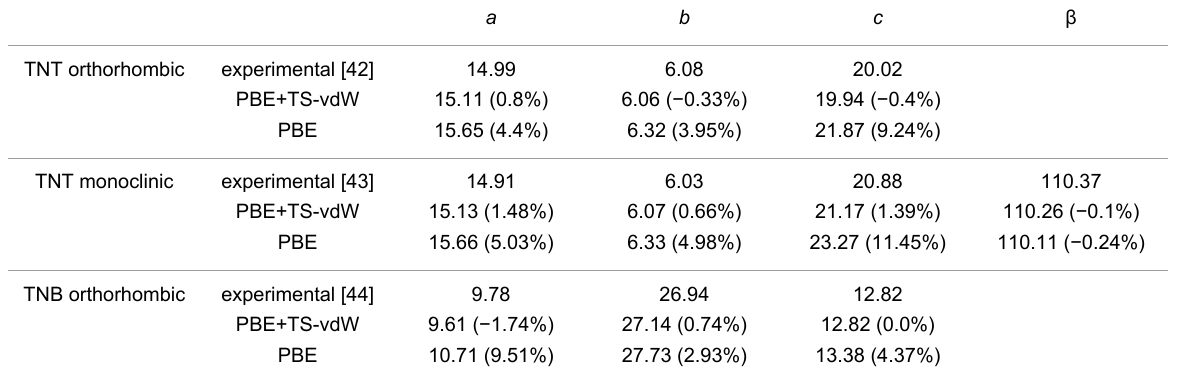
Table 1: Measured and computed lattice parameters for orthorhombic TNT, monoclinic TNT, and orthorhombic TNB. a , b , and c are lattice parame- ters (in Å) and β is the angle between a and c , in degrees, for the monoclinic polymorph. Numbers in parentheses indicate the relative error with respect to